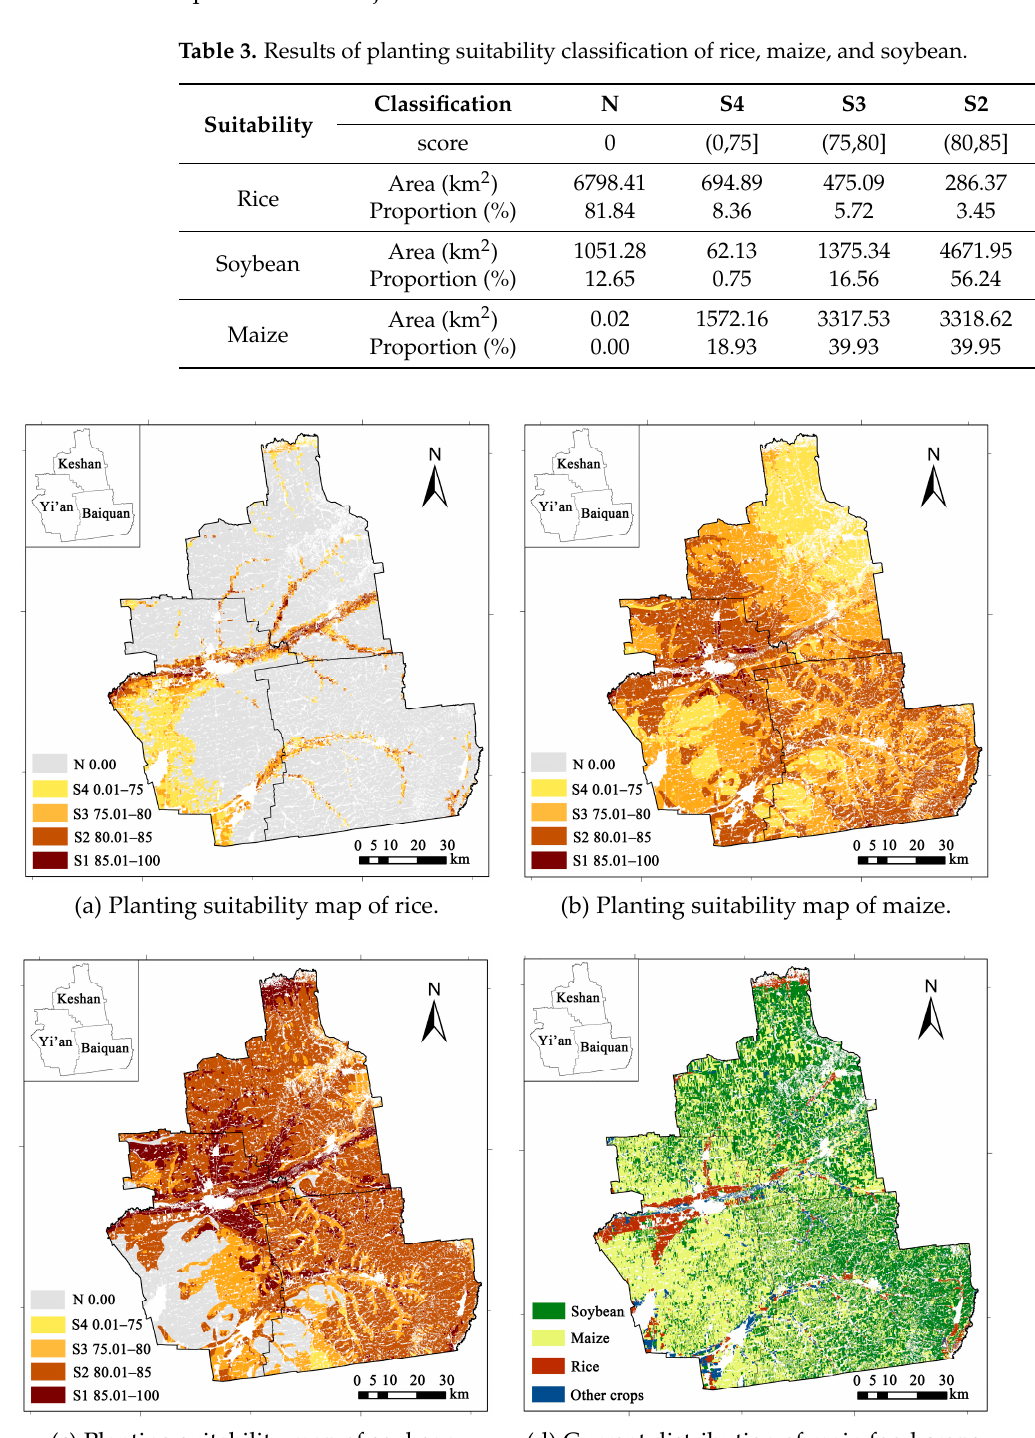
(c) Planting suitability map of soybean. (d) Current distribution of main food crops. Figure 3. The current distribution ( a ) and the planting suitability maps ( b, c, d ) of main food crops in the study